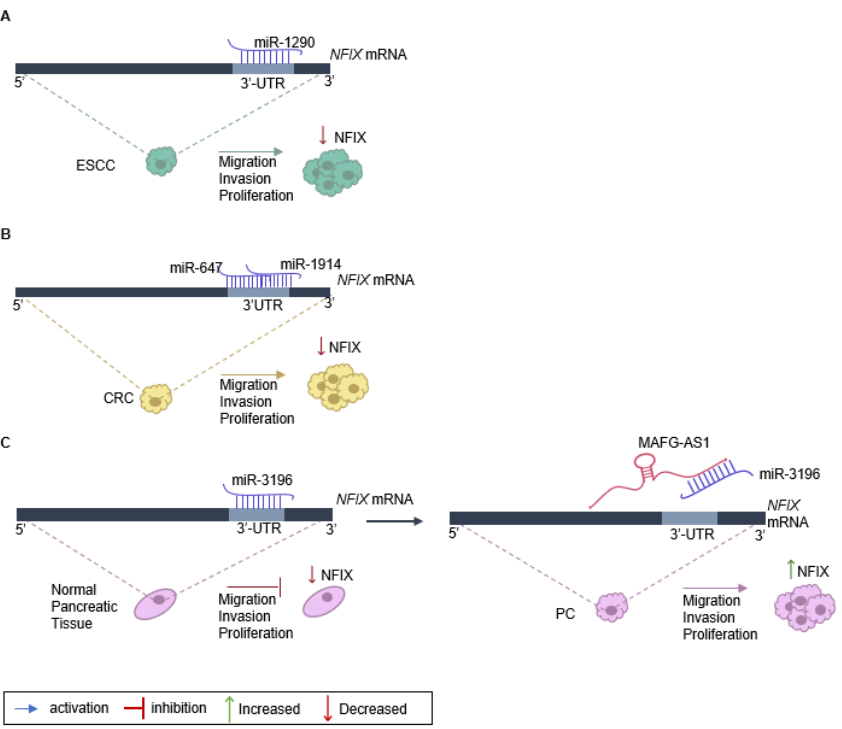
Figure 2. Regulation of NFIX expression in cancer . ( A ) NFIX regulation by miR-1290 promotes esophageal squamous cell carcinoma (ESCC) progression: miR-1290 directly targets the 3 (cid:48) UTR sites of NFIX mRNA, negatively regulating its expression. The decrease in NFIX expression leads to ESCC cell proliferation, migration, and invasion. ( B ) NFIX co-regulation by miR-647 and miR-1914 in colorectal cancer (CRC): NFIX mRNA is co-targeted by miR-647 and miR-1914 in the 3 (cid:48) UTR. The negative regulation of NFIX expression leads to CRC cell migration and invasion. ( C ) ceRNA network of MAFG-AS1/miR-3196/NFIX in pancreatic cancer (PC): in normal pancreatic tissue, miR-3196 directly binds to 3 (cid:48) UTR sites of NFIX mRNA and silences its expression. The lncRNA MAFG-AS1, highly expressed in PC cells, binds directly to the miR-3196, promoting NFIX upregulation and, as a consequence leading to proliferation, migration, and invasion of PC